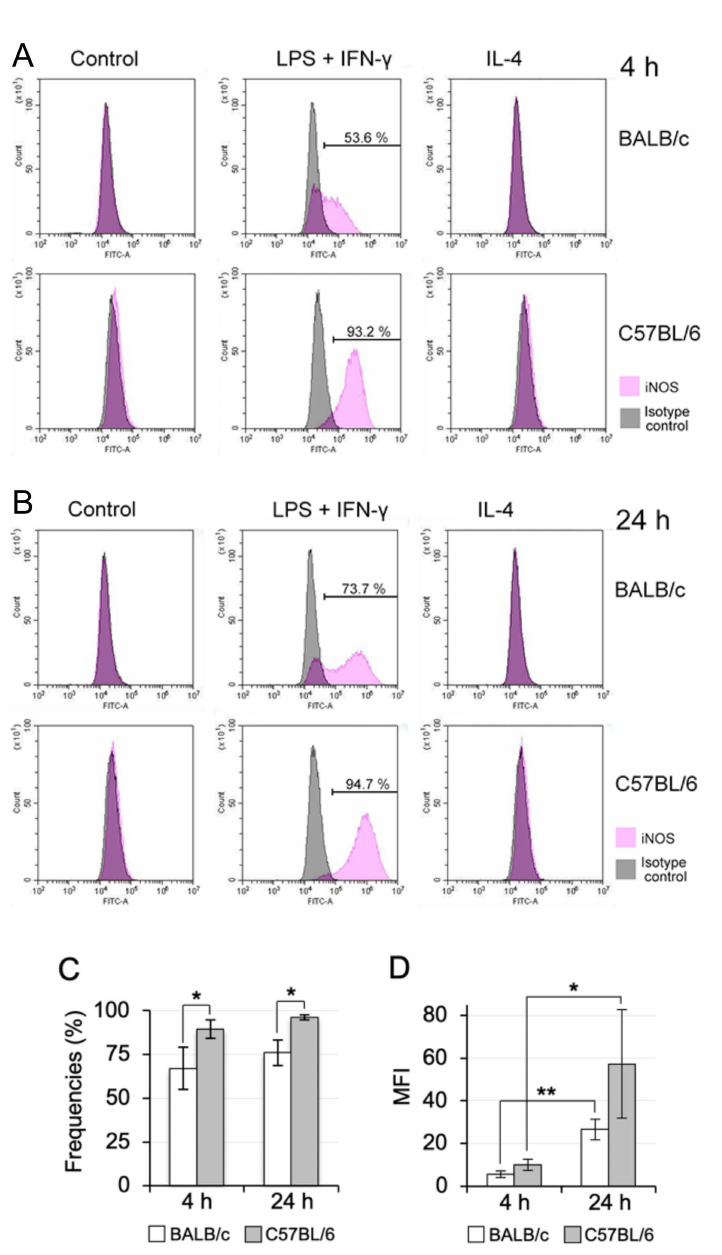
Figure 7. Comparison of the M1 polarisation property of BALB/c lung Mø propagated by co- culturing with that of C57BL/6 lung Mø. ( A , B ): Representative histograms from flow cytometric analyses demonstrating the expression of iNOS in propagated lung Mø of BALB/c mice and C57BL/6 mice treated with M1 (LPS plus IFN- γ ) and M2 (IL-4) polarisation inducer or without inducers (Control) for 4 h ( A ) and 24 h ( B ). The iNOS expression was induced only in lung Mø of both the mouse types treated with the M1 inducer: lung Mø of BALB/c mice treated with the M1 inducer for 4 h and 24 h consisted of the iNOS-positive and -negative fraction, while those of C57BL/6 mostly consisted of the iNOS-positive fraction. ( C , D ): Frequencies showing iNOS-positive cells ( C ) and the mean fluorescence intensities (MFI) of iNOS-positive cells ( D ) in the lung Mø of BALB/c mice and C57BL/6 mice treated with LPS plus IFN- γ for 4 h and 24 h. Percentages and the MFI of iNOS-positive cells determined from three independent experiments of lung Mø from three mice and presented as mean ± SD (* p < 0.05, ** p <